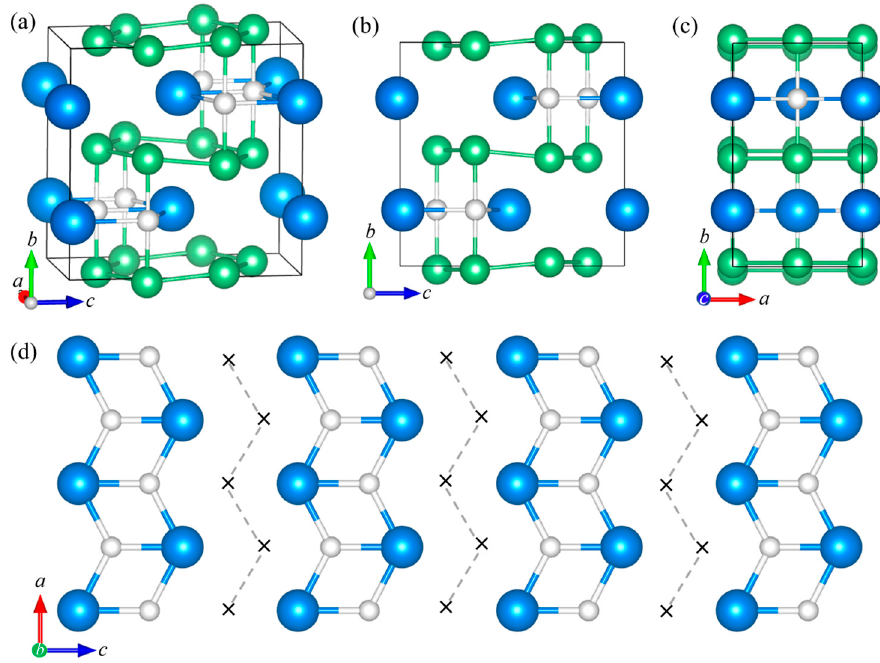
Figure 2. ( a ) Orthorhombic Imma crystal structure of ZrBe 2 H. Blue, green, and white spheres repre- sent Zr, Be, and H, respectively. Analogous to the hexagonal P 6/ mmm ZrBe 2 H x structure in Figure 1, alternate ac -planar layers of Zr and Be atoms form the parent ZrBe 2 structure with H atoms occu- pying specific trigonal Zr 3 (4 e ) sites in the Zr plane, which cause a rippling of the Be layers. ( b ) View along the a -axis. ( c ) View along the c -axis. ( d ) View along the b -axis, showing just the Zr layer and the ordered pattern of H-site occupation forming zigzag chains of H atoms along the a -axis, sepa- rated by zigzag chains of vacancies (×).